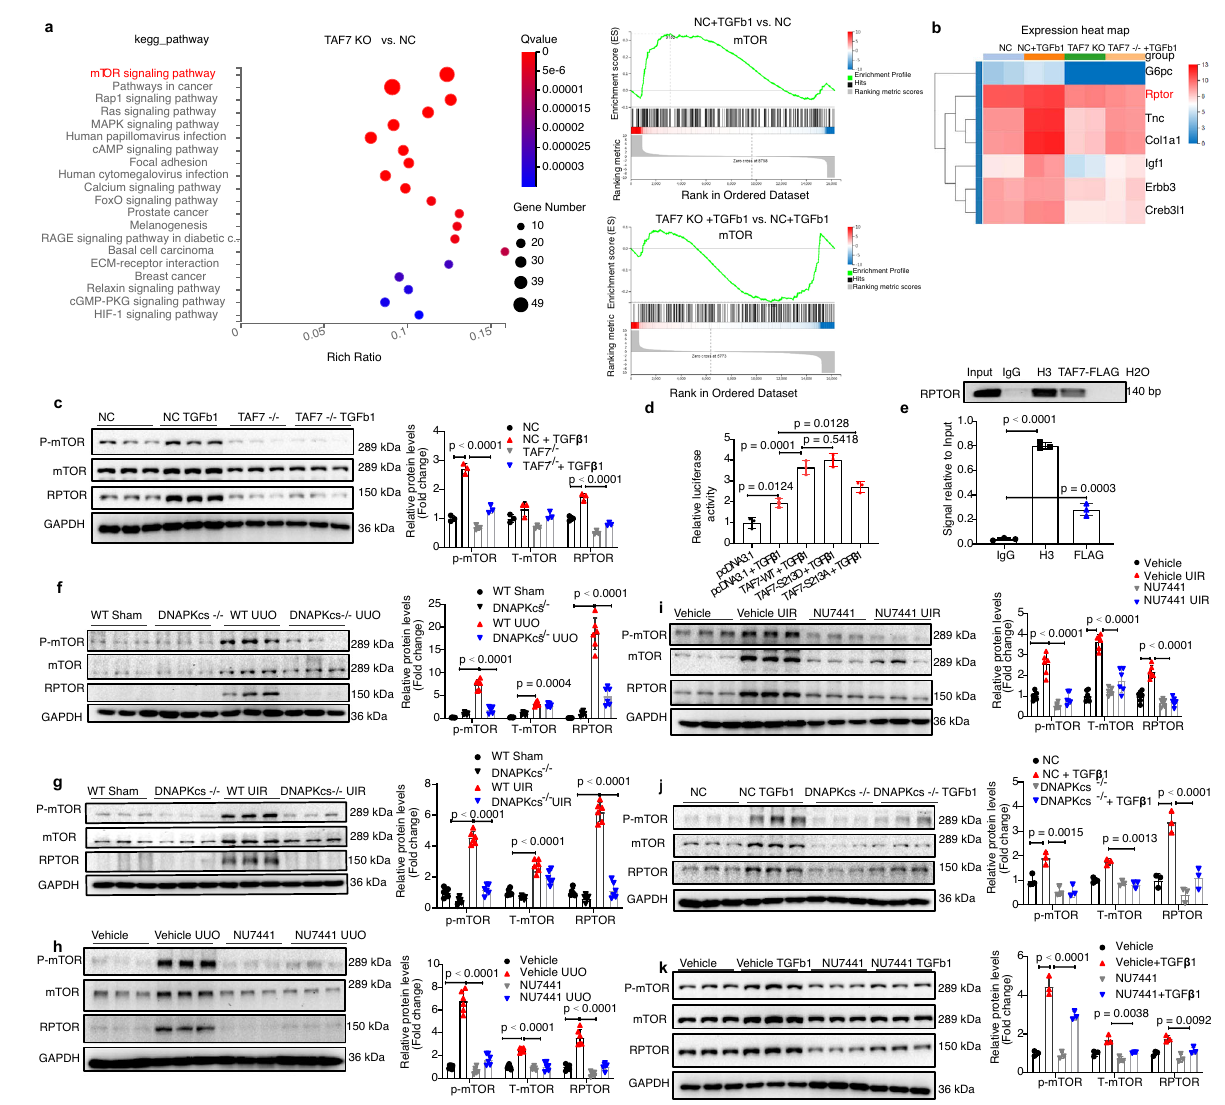
Fig. 6 | DNA-PKcs-mediated phosphorylation of TAF7 promotes mTORC1 acti- vation by upregulating RPTOR expression. a RNA-seq showing that mTOR sig- naling (indicated by red font) was the top differentially expressed signaling factor between the TAF7 − / − and NC groups. GSEA showing that mTOR signaling was upregulated inthe NC+TGF β 1 group and suppressedin theTAF7 − / − +TGF β 1group (n=2), TGF β 1 (5ng/ml) treatment for 24h. b Heatmap image showing that Rptor (indicated by red font) was decreased in the TAF7 − / − groups compared to the NC groups with or without TGF β 1 (5ng/ml) treatment for 24h ( n =2 of each group). c Protein levels of RPTOR, mTOR and phosphorylated mTOR analyzed by Western blotinTAF7 − / − and NCmPTCstreated withTGF β 1 (5ng/ml)for24h.Barsrepresent quanti fi cation results (mean±SD, n =3 independent experiments). d Luciferase reporterassayinHK-2cellswithTGF β 1(5ng/ml)for24h.Barsrepresentresultsof3 independent experiments (mean±SD). e ChIP assay was performed to analysis